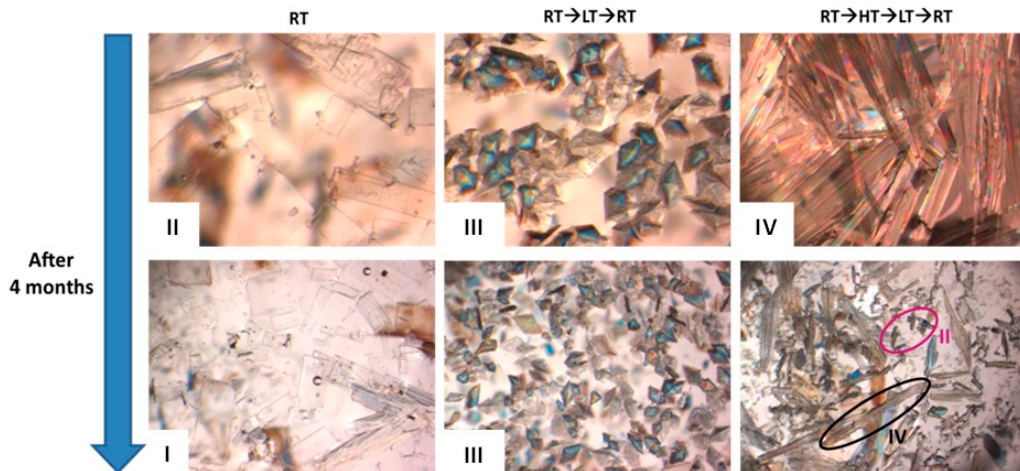
Figure 3. Crystal images of GBP polymorphic forms obtained in C 4 mimBF 4 + C 6 mimBF 4 after crystallization and after 4 months [44]. Images obtained using an optical microscope.